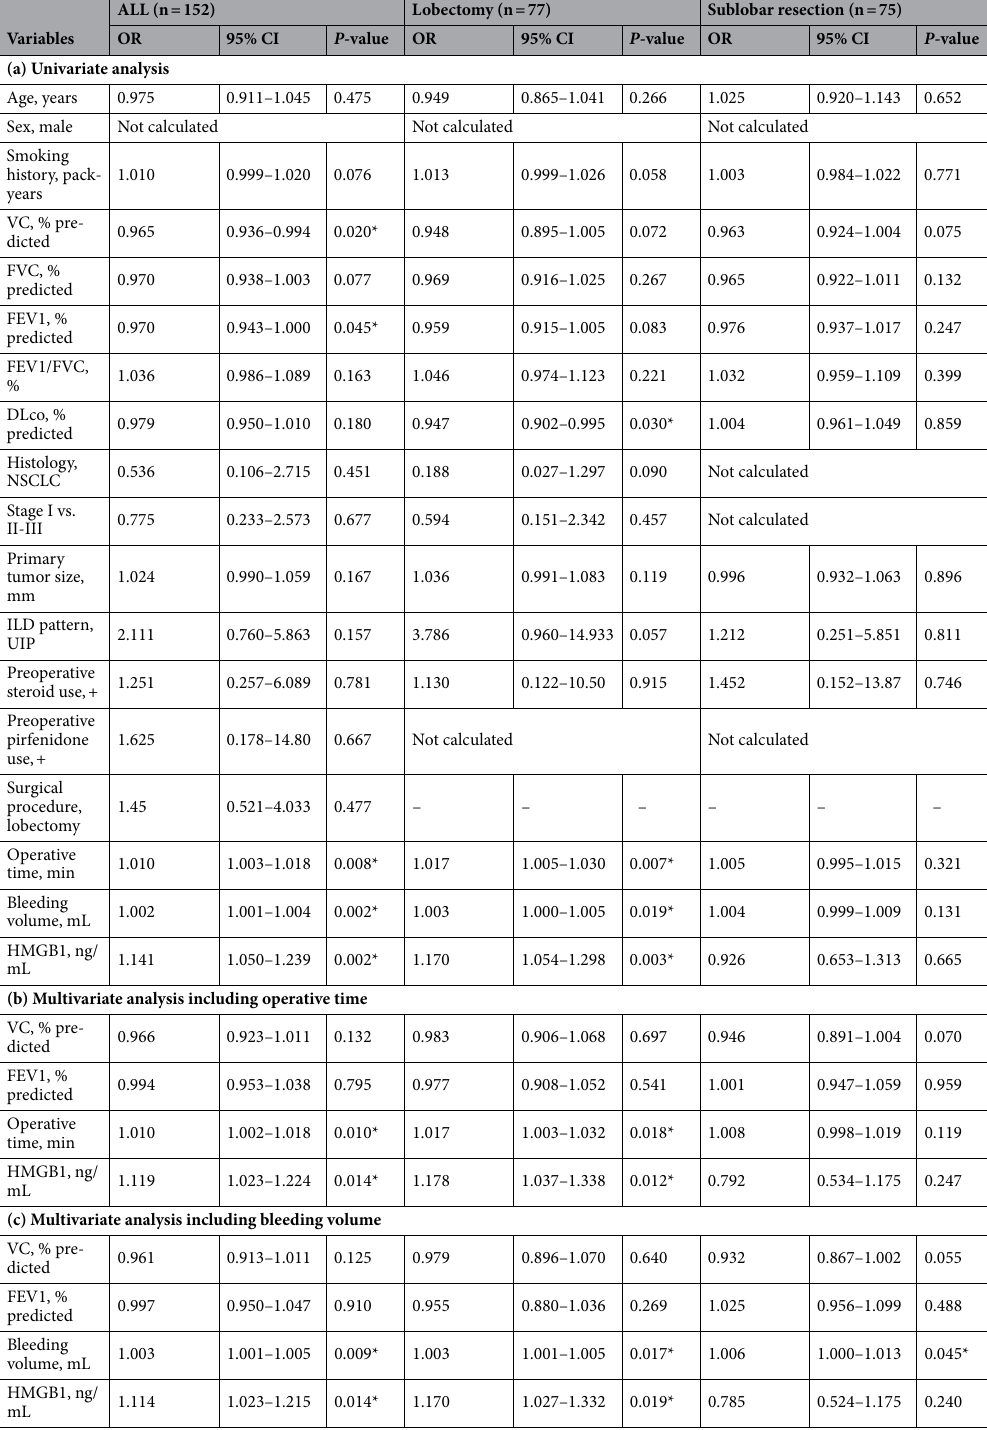
Table 3. Logistic regression analysis of the risk factors of postoperative AE-ILD. AE-ILD acute exacerbation of interstitial lung disease; OR Odds ratio; CI confidence interval; DLco diffusing capacity for carbon monoxide; FEV1 forced expiratory volume in one second; FVC forced vital capacity; HMGB1 high-mobility group box 1; ILD interstitial lung disease; NSCLC non-small cell lung cancer; SCLC small cell lung cancer; UIP usual interstitial pneumonia; VC vital capacity. * P < 0.05 Logistic regression